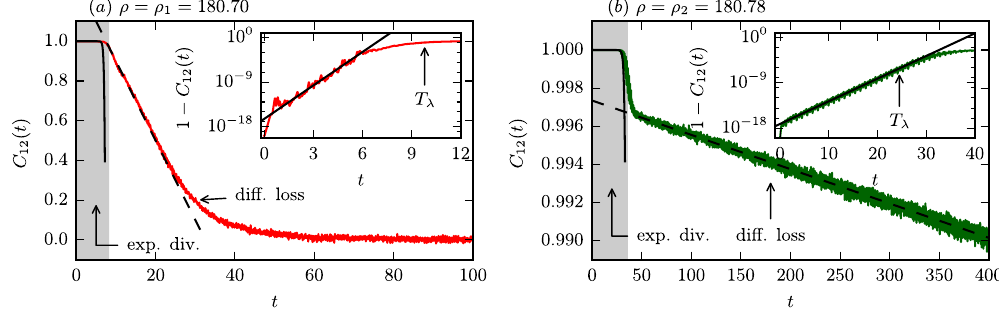
Figure 4. The cross-correlation C 12 for pairs of trajectories with an initial distance δ = 10 − 8 and averaged over 10 4 pairs over time. The data is for ( a ) strong chaos ( ρ = ρ 1 = 180.70) and ( b ) partially predictable chaos ( ρ = ρ 2 = 180.78); compare Fig. 1. For both cases we find an initial time interval of exponential decorrelation (shaded gray). The blow-ups magnifying that region show that the correlation C 12 ≈ 1 initially decreases with − . ⋅ λ − e 1 2 8 10 t 13 C , λ = 5.17 (inset in ( a )) and as − . ⋅ λ − e 1 4 7 10 t 14 C , λ = 1.04 (inset in ( b )), as indicated by C C the respective solid lines. The linear decrease of C 12 for intermediate times corresponding to a diffusive loss of predictability is ∝ ( − 0.04 t ) in ( a ) and ∝ ( − 1.8 · 10 − 5 t ) in ( b ), as indicated by the respective dashed